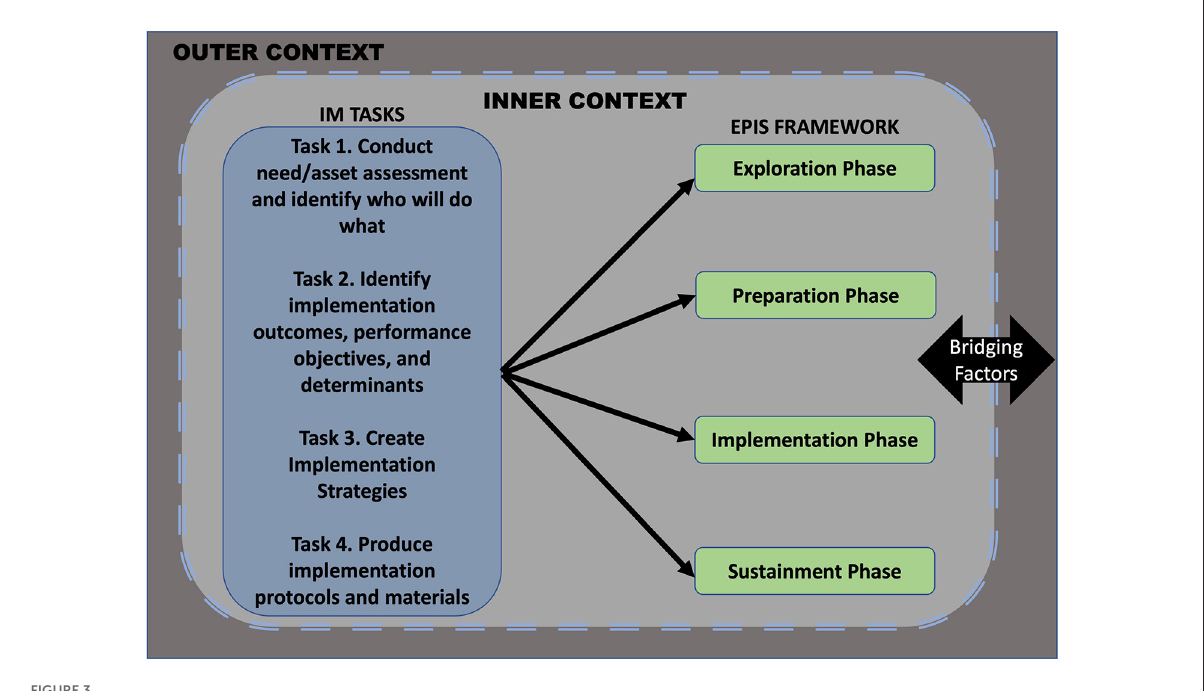
FIGURE3 EPIS-informed implementation mapping